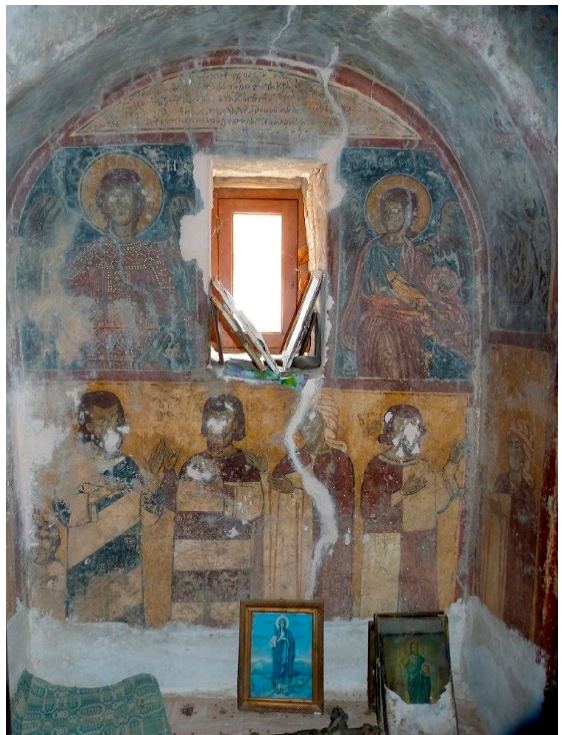
Figure 24. Lay donor under the protection of the Archangels Michael and Raphael, 1327–1328, church of the Archangel St Michael in Kavalariana (Kandanos, Selinou) (Crete), north wall. ©